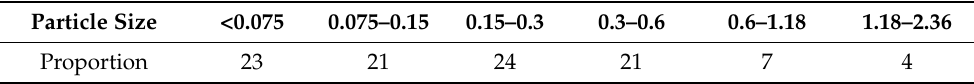
Table 4. Blockage grading table.